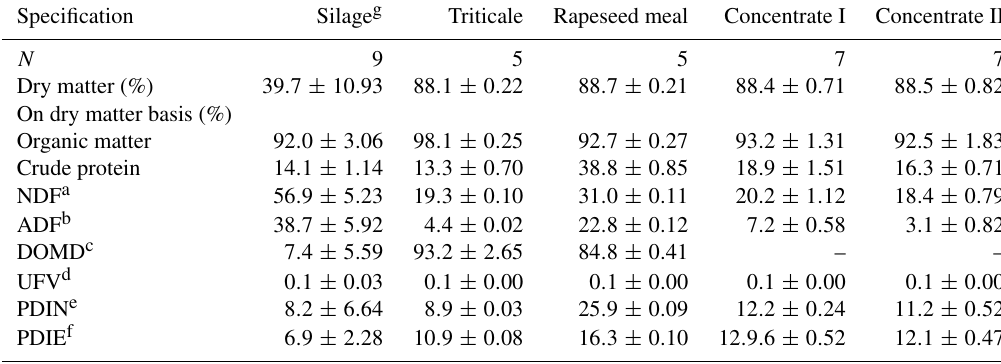
Table 1. Chemical composition and nutritional value of experimental diets (mean ± SD). Specification Silage g Triticale Rapeseed meal Concentrate I Concentrate II N 9 Dry matter (%) 39 . 7 ± 10 . 93 On dry matter basis (%) Organic matter 92 . 0 ± 3 .